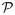
Scatterplots of the first attended locations P predicted by the saliency algorithms.A: P for target-present images in the Potter set. B: P for images with no target present from Potter set. C: P for target-present images in the Thorpe set. D: P for images with no target present from Thorpe set.